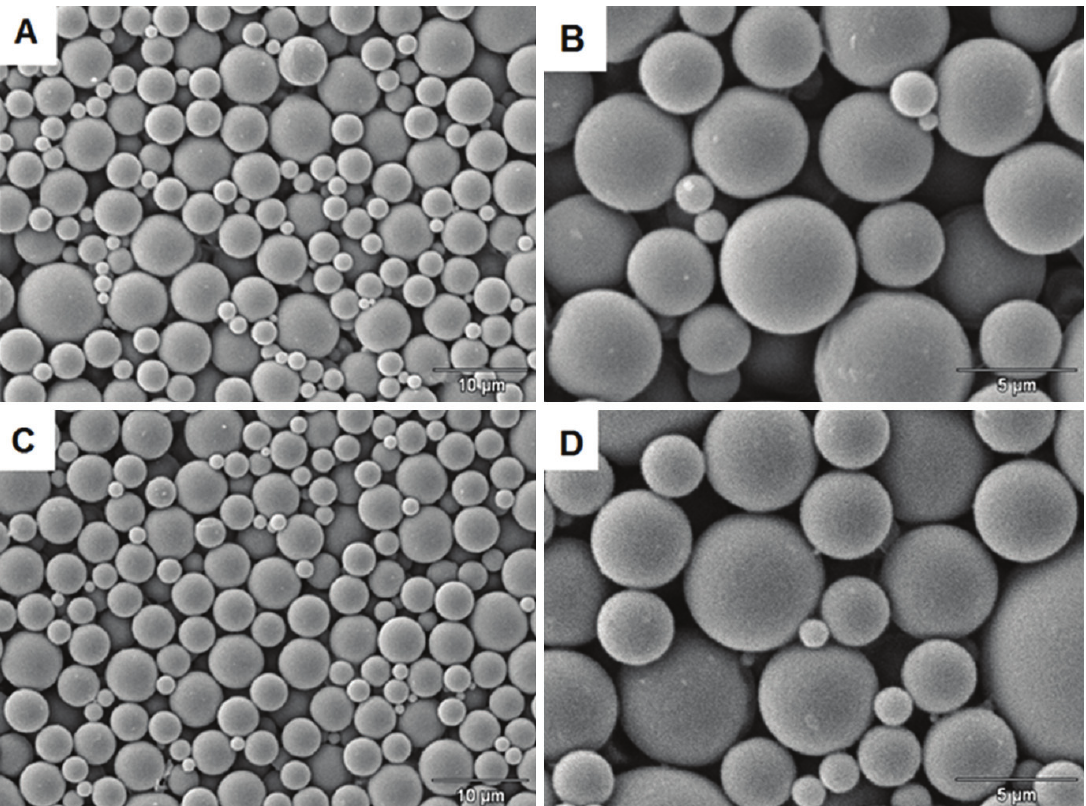
Figure 3. Scanning electron micrographs of microspheres. (A) and (B) – PLDLA microspheres without paclitaxel, (C) and (D) – PLDLA microspheres with